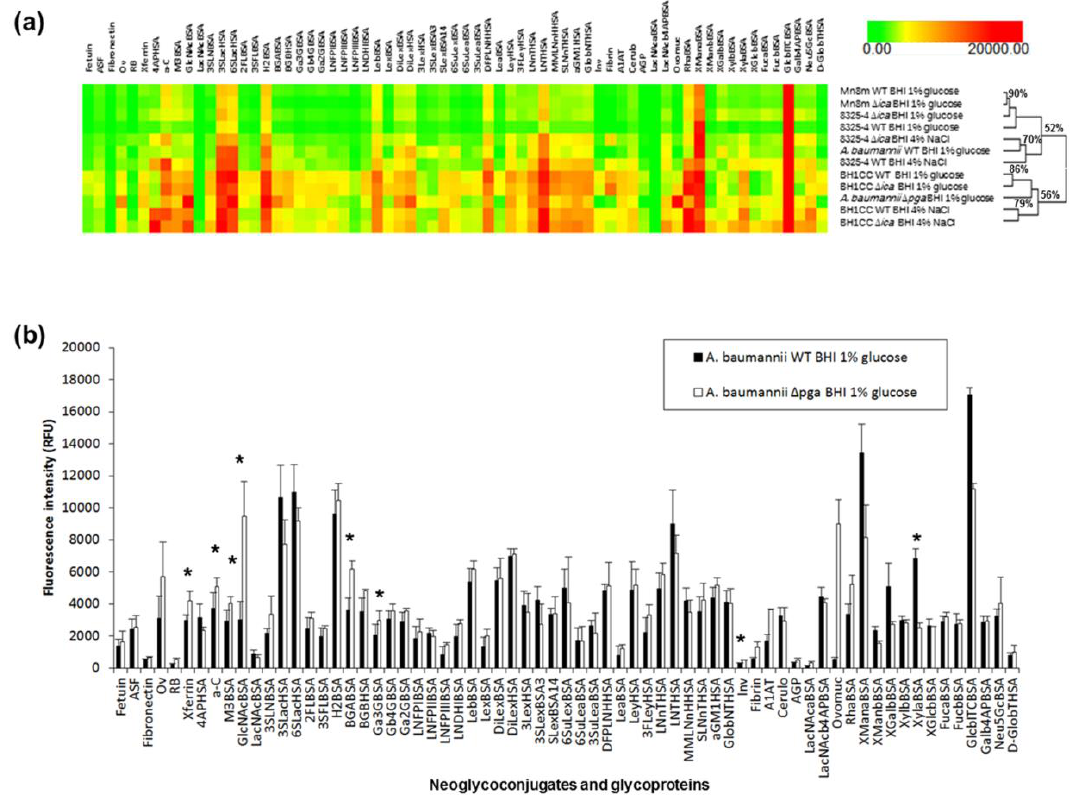
Figure 5. Carbohydrate binding intensities of bacterial strains. ( a ) Unsupervised hierarchical clustering of carbohydrate microarray binding intensities for S. aureus Mn8m, 8325-4, BH1CC and A. baumannii all grown in BHI supplemented with 1% glucose, and supplemented with 4% NaCl for S. aureus 8325-4 and BH1CC. Binding intensity data was scale-normalised to 20,000 RFU maximum and clustered using Hierarchical Clustering Explorer v3.0 with complete linkage and Euclidean distance. ( b ) Bar chart representing carbohydrate binding intensities of A. baumannii WT and ∆ pga grown in BHI glucose. Bars represent the mean of three experiments with error bars of +/ − 1 SD of the mean. * represents significant di ff erence ( p ≤ 0.05, calculated by Student’s t-test, two tailed) in binding between WT and ∆ pga .